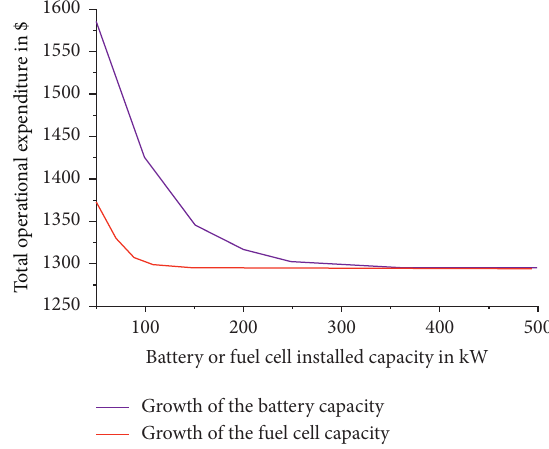
Figure 12: Total operating cost for various capacities of the fuel cell and